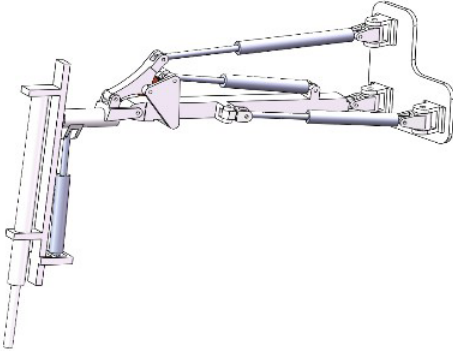
Figure 5. A 3D model of a new drilling arm mechanism with 4 DOFs.